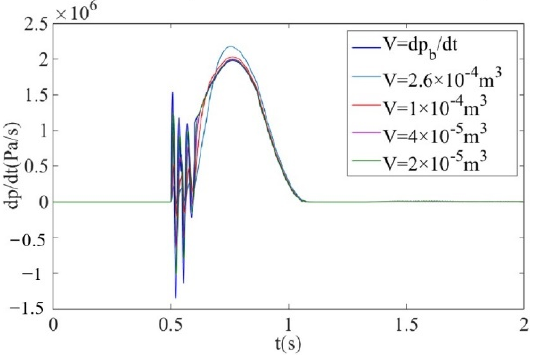
Figure 6. Simulation results of different isothermal container volumes.